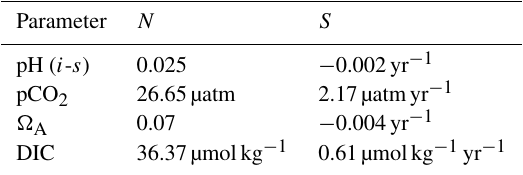
Table A1. Values of natural variability ( N ; the standard deviation of the annual means of each parameter) and theoretical acidification rate ( S ; the slope of the theoretical acidification curve) used in the time of emergence calculations.